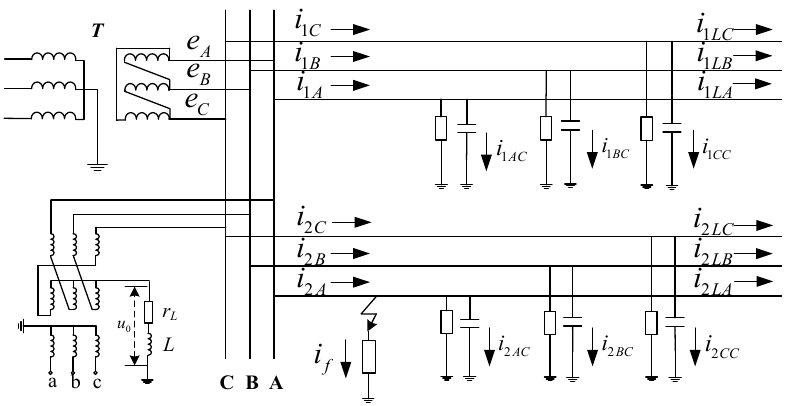
Figure 4. Currents of a phase-to-ground fault distribution system. T is the HV/MV transformer. L is the equivalent inductance of the arc suppression coil. r L is the equivalent inductance of the arc suppression coil. u 0 is the neutral point voltage before the fault. i f is the fault current at the grounding point. e A , e B and e C , respectively, are the effective values of phase A, phase B and phase C. i 1 A , i 1 B and i 1 C , respectively, are the phase currents of phase A, phase B and phase C near the bus bar on line 1. i 1 LA , i 1 LB and i 1 LC , respectively, are the load currents of phase A, phase B and phase C on line 1. i 1 AC , i 1 BC and i 1 CC , respectively, are the capacitance currents to the ground of phase A, phase B and phase C on line 1. i 2 A , i 2 B and i 2 C are the phase currents on line 2. i 2 LA , i 2 LB and i 2 LC are the load currents on line 2. i 1 AC , i 1 BC and i 1 CC are the capacitance currents to the ground on line